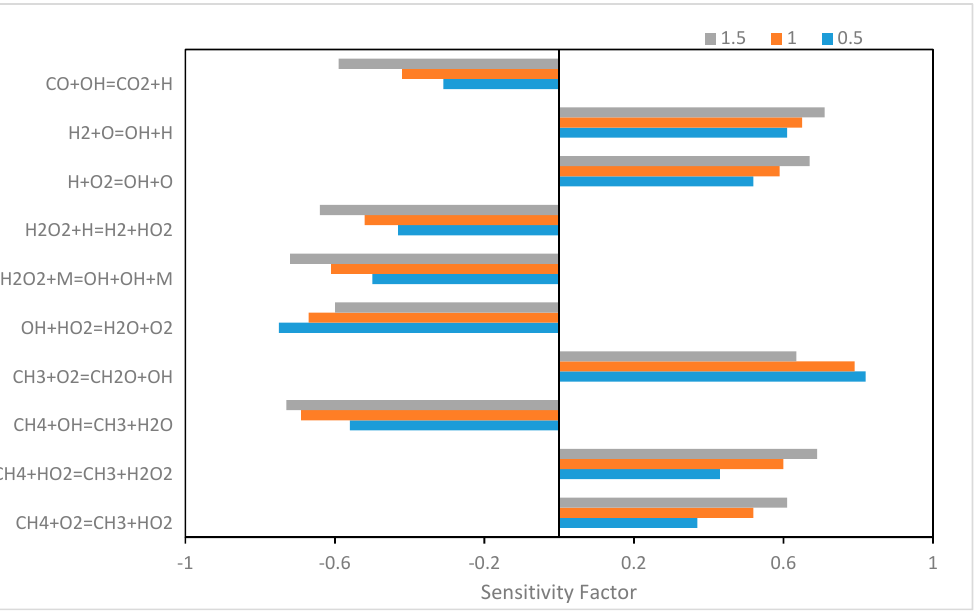
Figure 11. Ten most sensitive reactions for Fuel 6: H 2 /CO/CH 4 30/30/40%, at pressure 10 bar, temperature 1125 K and equivalence ratios 0.5, 1.0 and 1.5.